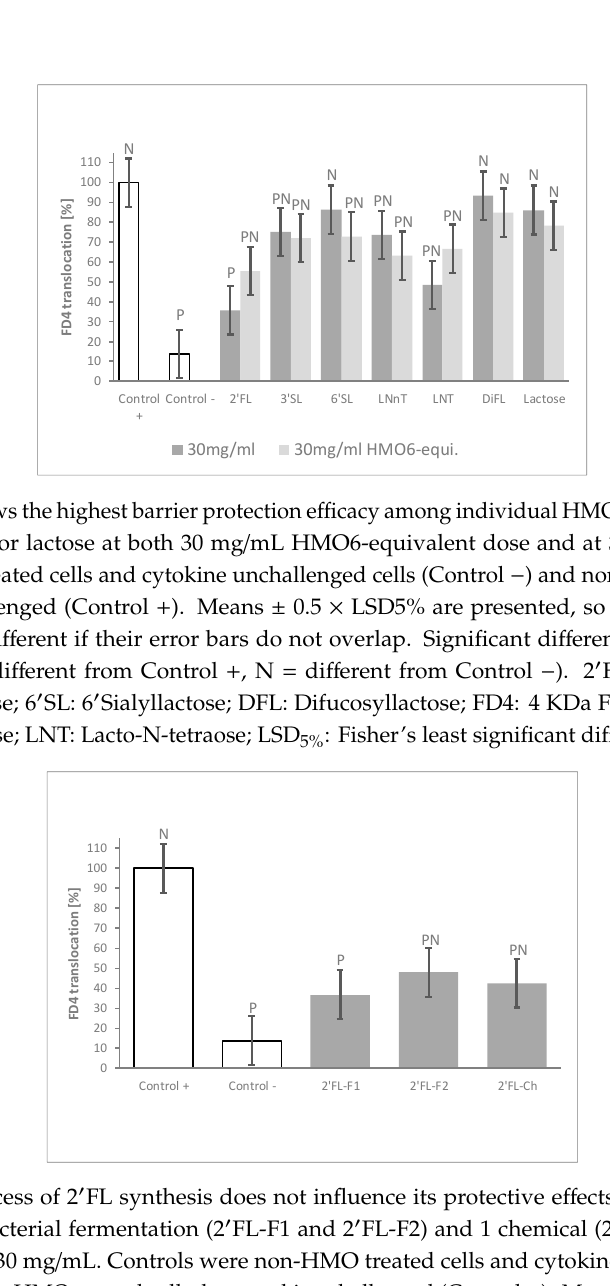
Figure 4. The process of 2 ′ FL synthesis does not influence its protective effects. FD4 translocation with 2 different bacterial fermentation (2 ′ FL-F1 and 2 ′ FL-F2) and 1 chemical (2 ′ FL-Ch) production batches of 2 ′ FL at 30 mg/mL. Controls were non-HMO treated cells and cytokine unchallenged cells (Control –) and non-HMO treated cells, but cytokine challenged (Control +). Means ± 0.5 x LSD5% are presented, so that two conditions are significantly different if their error bars do not overlap. Significant differences vs. controls are highlighted (P = different from Control +, N = different from Control − ). 2 ′ FL: 2 ′ Fucosyllactose; FD4: 4 KDa FITC-Dextran; LSD 5% : Fisher’s least significant experienced a significant increase in FD4 translocation, with levels of cell cytotoxicity lower than difference with α = 5%. 35% of lysed cells (data not shown). FD4 translocation was reduced by HMO6 in a